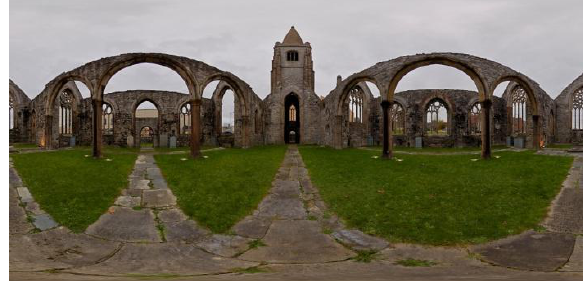
Figure 5 Panorama created in the middle of the ruin .